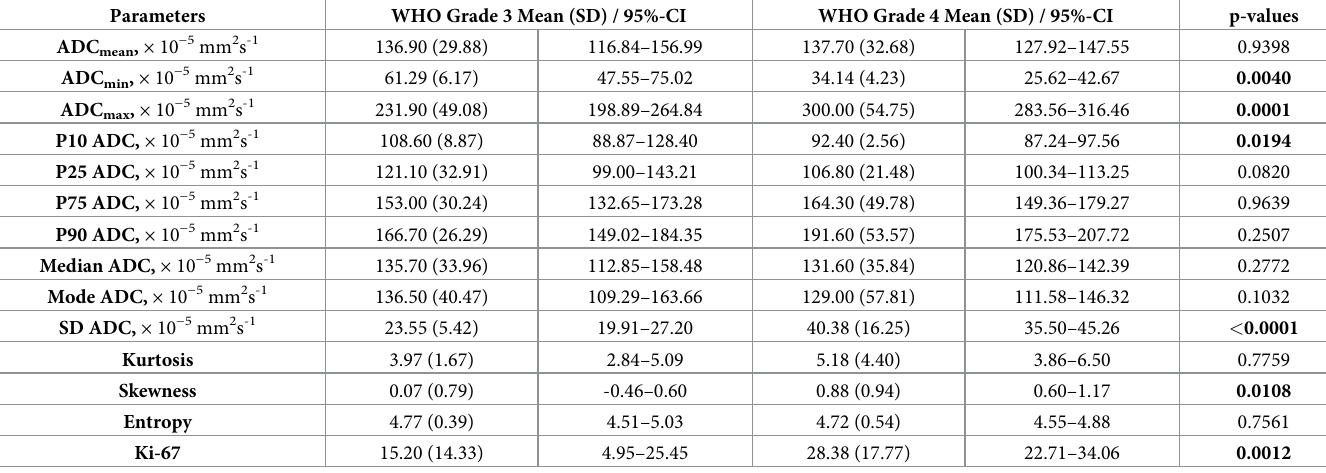
Table 2 compares DWI histogram profiling values of WHO grade III and WHO grade IV gliomas. P-values of statistically different comparisons are given in bold writing.